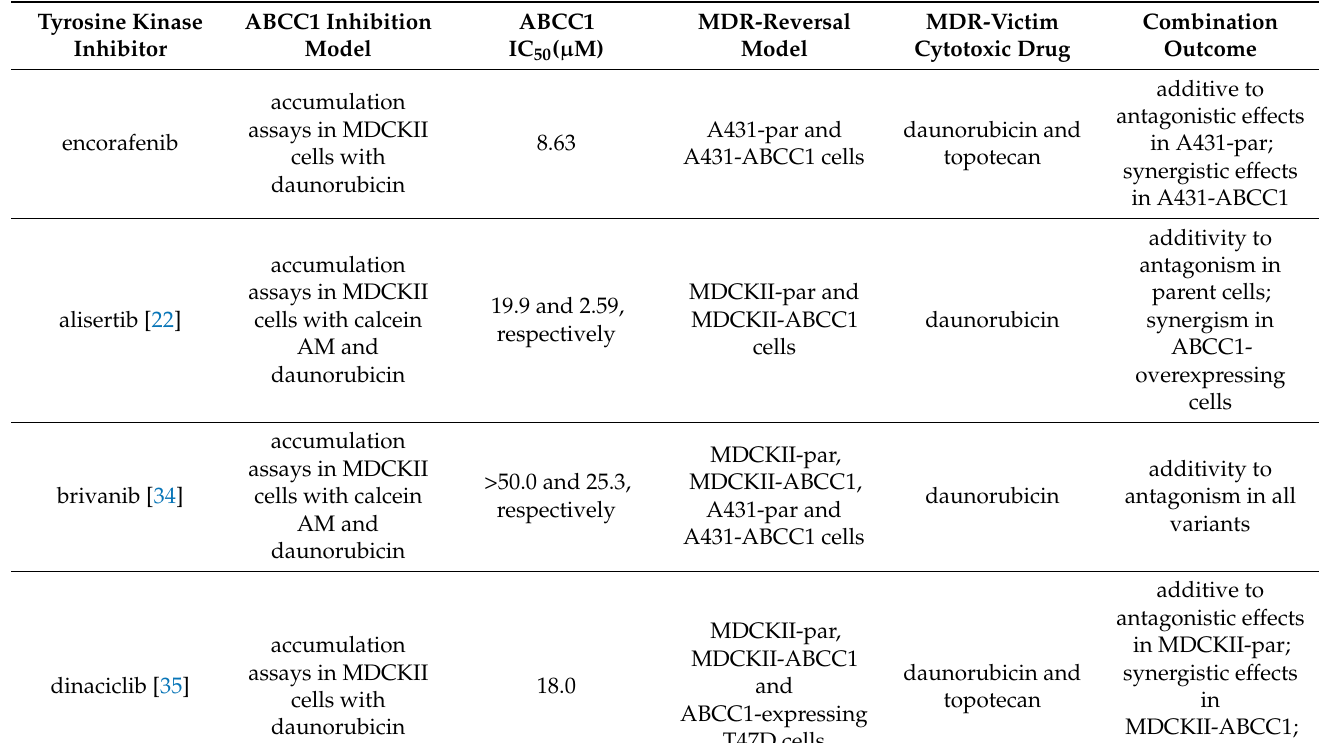
Table 2. Summary of ABCC1 inhibitory effects and associated MDR-combating potentials of approved or clinically evaluated (phase II/III) tyrosine kinase inhibitors. NA, not